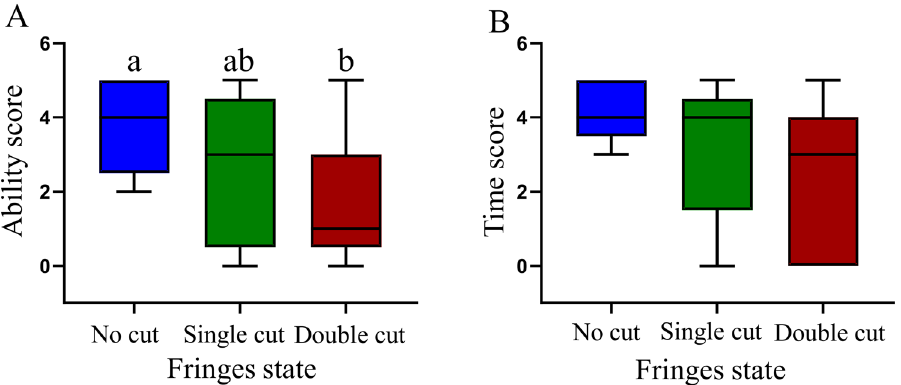
Figure 4. Ability scores ( A ) and time scores ( B ) for sand-burying by Phrynocephalus mystaceus under different states. Note: Different letters indicate significant differences at the P < 0.05